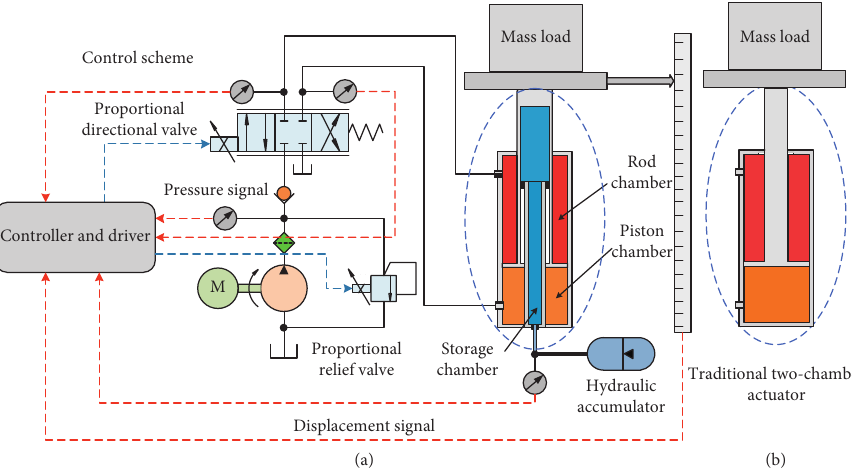
Figure 1: Simplified schematic of the proposed direct drive and energy recuperation hydraulic servo system (a) and the traditional two- chamber hydraulic actuator